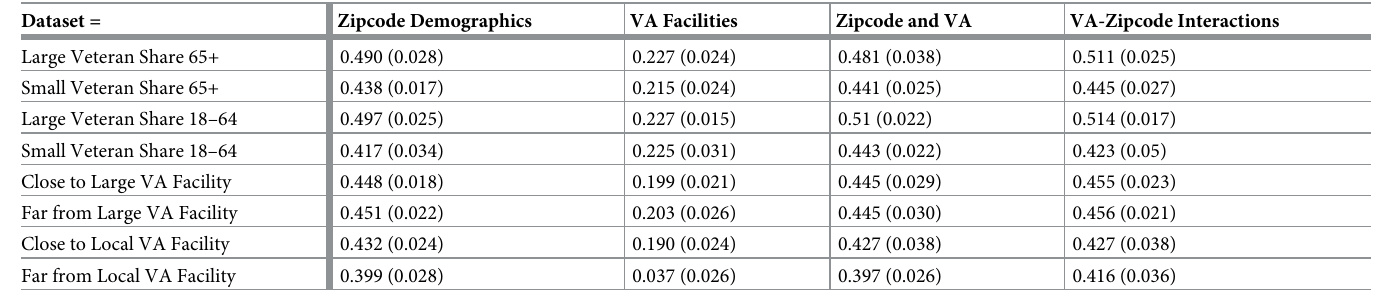
Table 4. Model R 2 performance metrics over all subgroups and